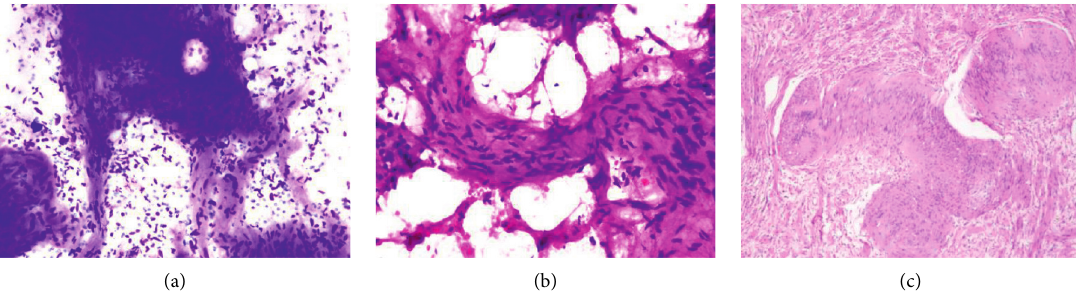
Figure 3: Schwannoma. (a) Imprint smear showing clusters and palisades of spindle cells (MGG stain, X100). (b) Scrape smear showing cluster of spindle cells having elongated wavy nuclei (H&E, X400). (c) Spindle-shaped tumor cells with bland nuclear chromatin seen on paraffin-embedded sections. Nuclear palisading leading to Verocay body formation noted (H&E,